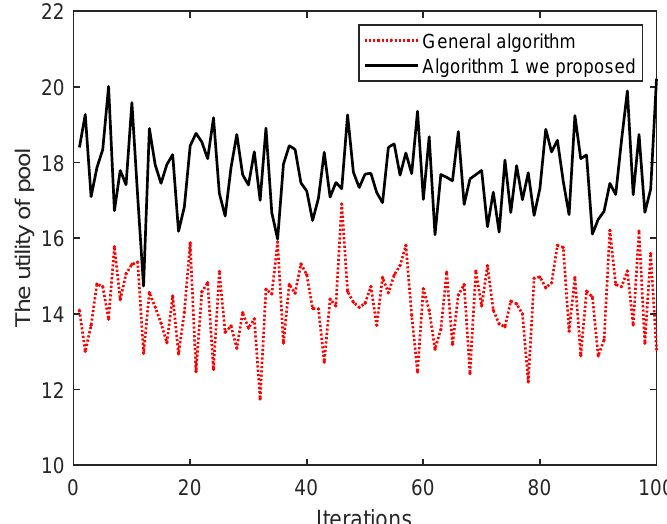
Figure 11. Iterations vs. The utility of